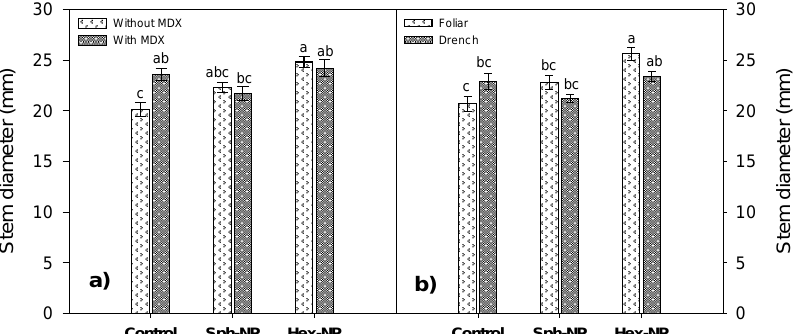
Figure 7. Effect of ZnO-NPs application on stem diameter. ( a ) Morphology*MDX interaction, ( b ) morphology and application method interaction. Bars represent the standard error of the mean. Different letters indicate significant differences according to Tukey´s multiple comparison test ( p < 0.05).